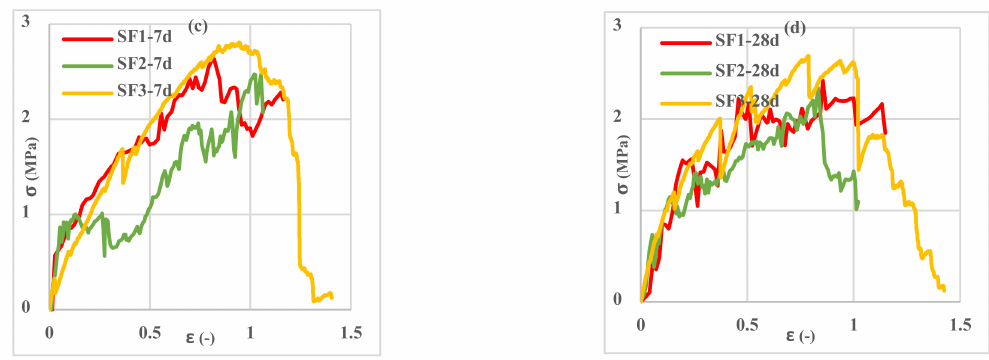
Figure 10. Tensile stress–strain curves of reinforced mortar with 3 types of spacer fabrics in the warp direction cured at 23 ◦ C